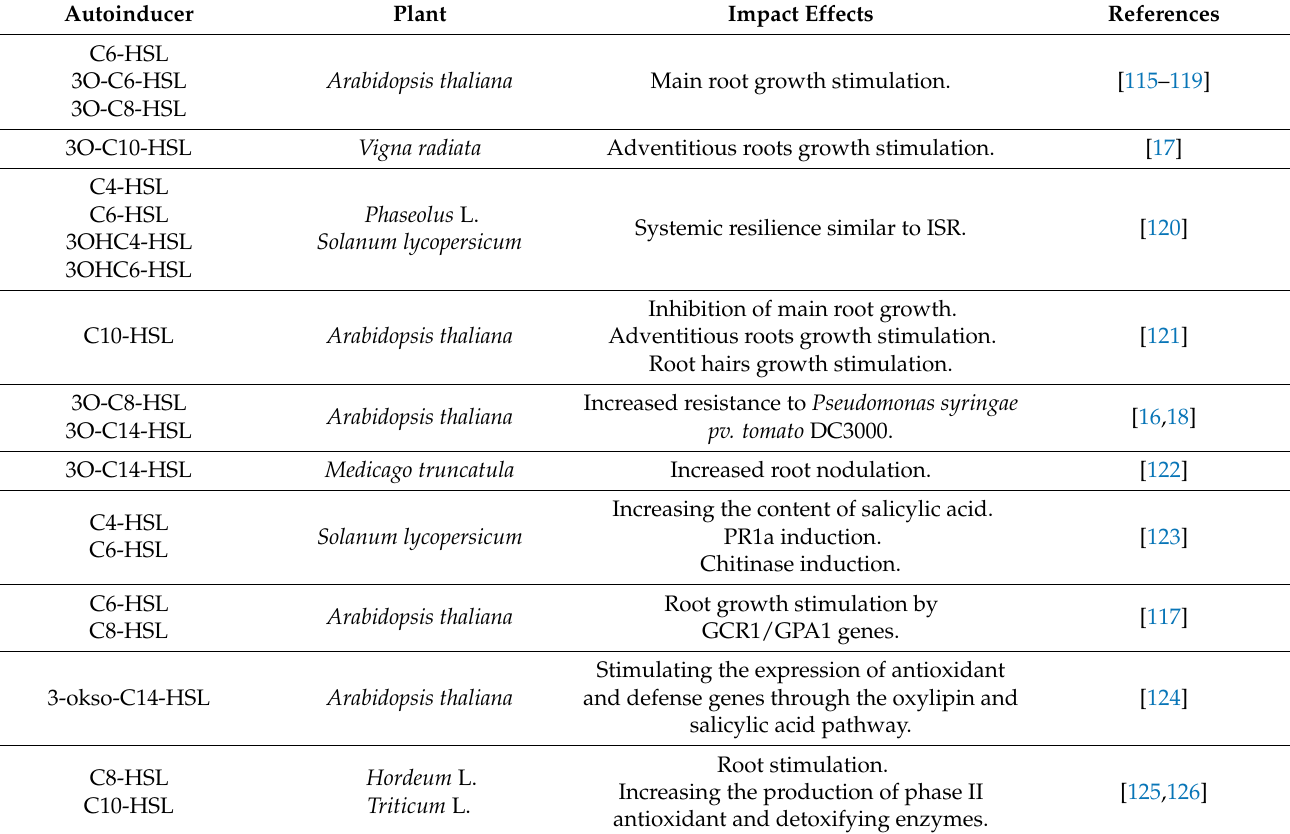
Table 2. The effects of the interactions of AHL molecules with different carbon chain lengths. Autoinducer